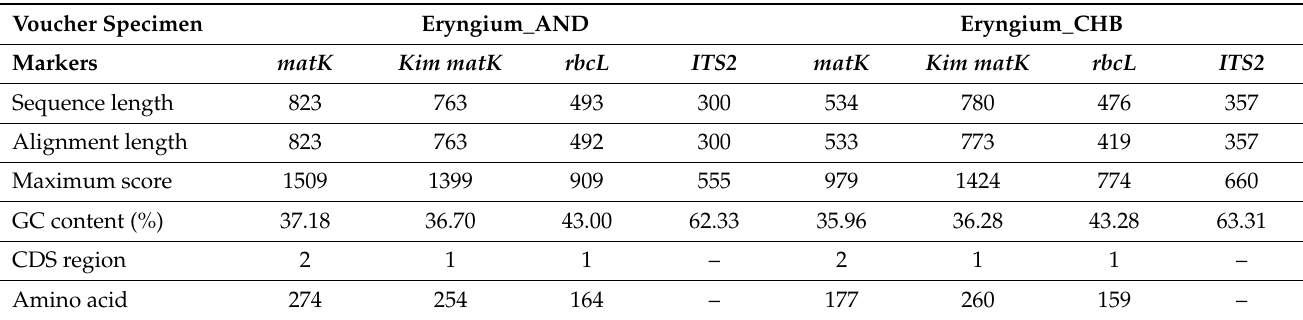
Table 3. Sequence characteristics, and the intraspecific and interspecific genetic divergence of candi- date